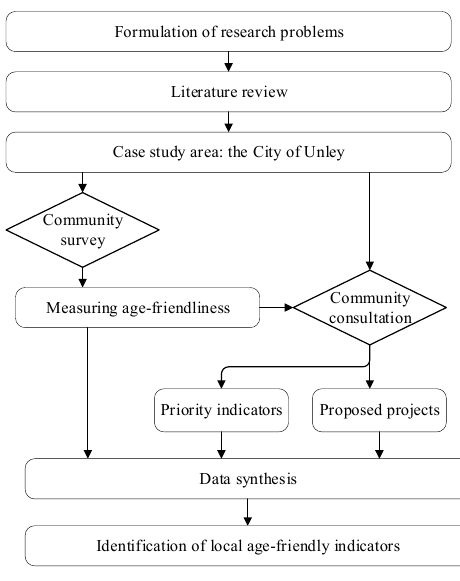
Figure 3. The key methodological approaches.